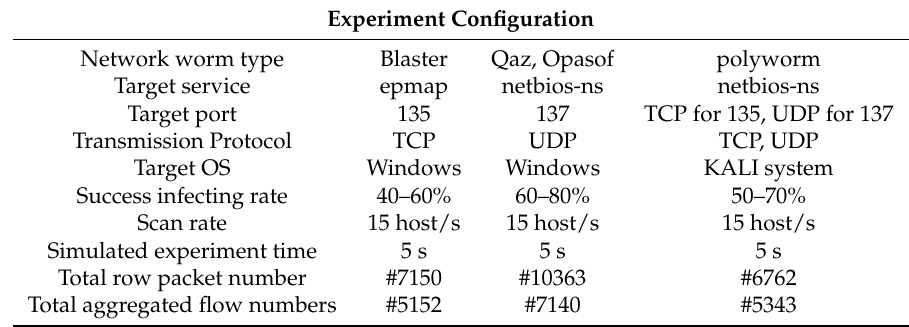
Table 1. Input parameters of experiment configuration for the simulated network worm